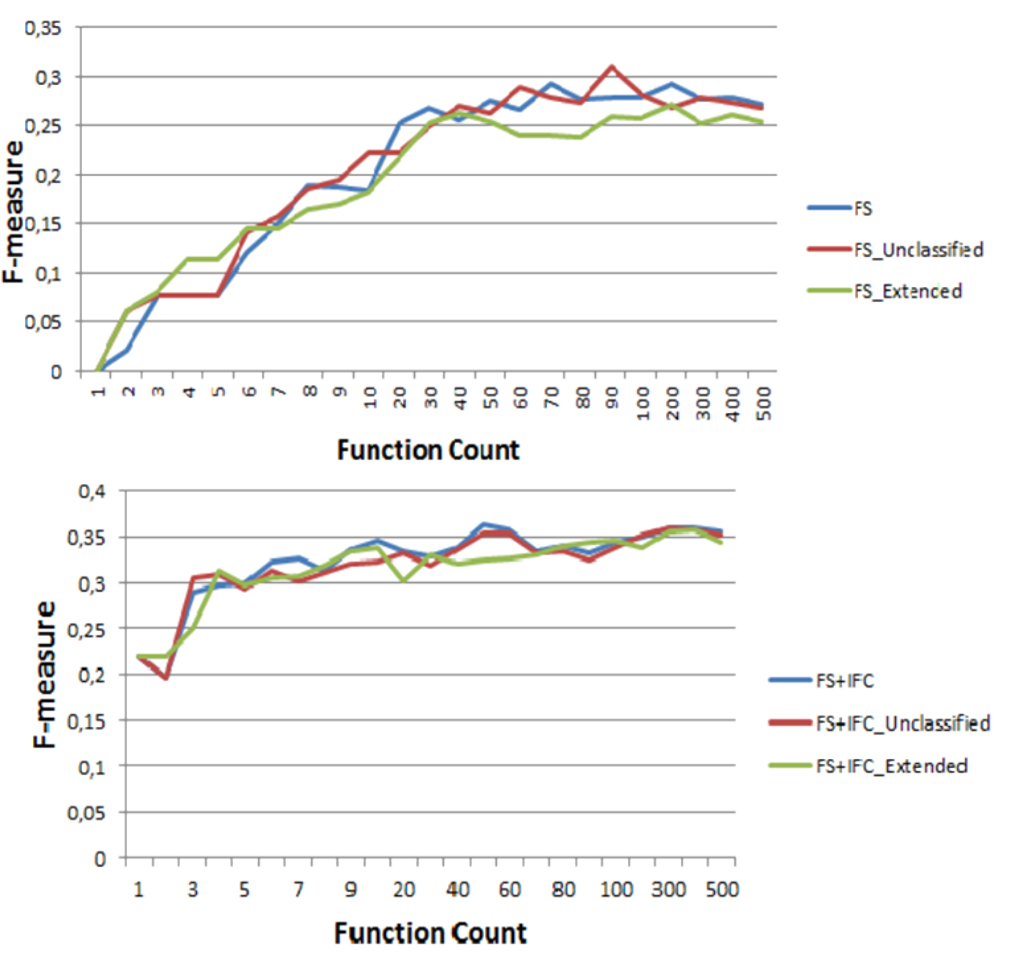
Figure 2: Comparing different Functional Context methods with their enriched functional ver- sions. There is no major difference between the original methods employed, compared to their respective functionally enriched